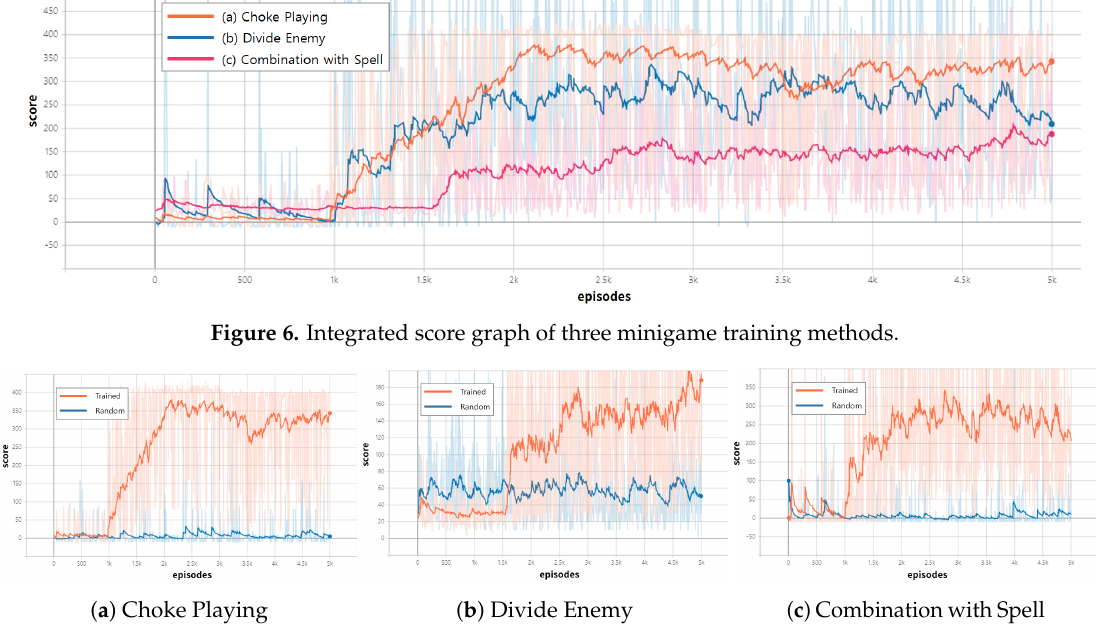
Figure 7. Score graphs over 5000 episodes of training.